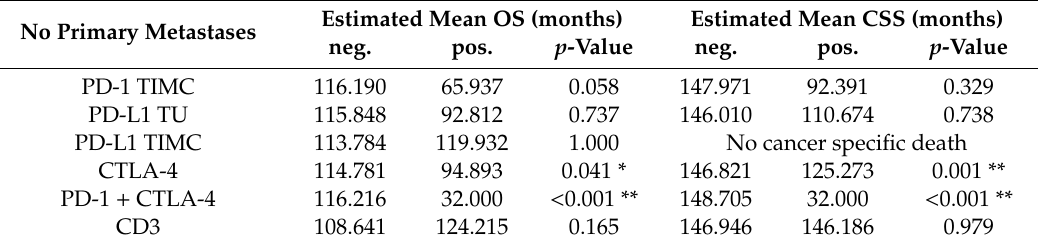
Figure 7. Kaplan Meier analysis: Association of combined PD-1 and CTLA-4 expression with CSS in all RCC patients. Table 5. Survival analysis (Log rank test) in the no primary metastases